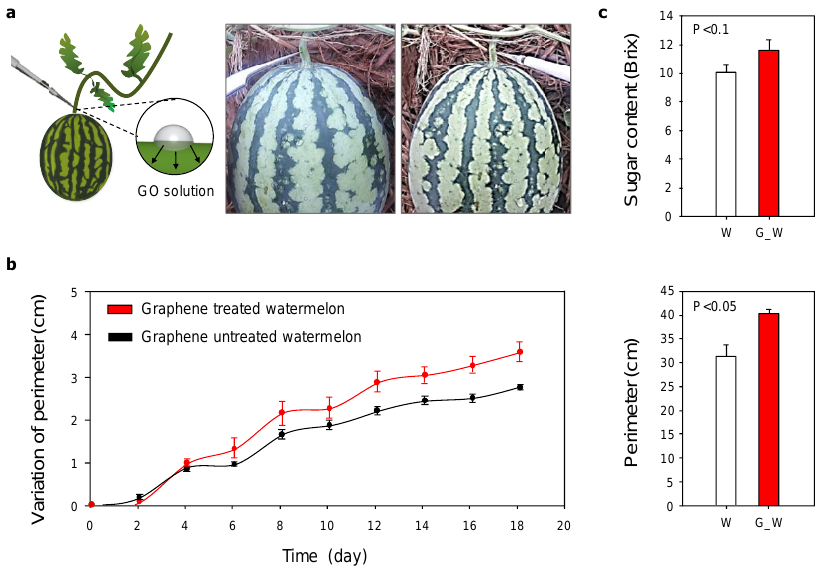
Figure 3. Effect of graphene oxide (GO) on watermelon. ( a ) Schematic of GO solution injection into the watermelon stem. ( b ) Effect of GO on the rate of perimeter change and the final watermelon perimeter. ( c ) Sugar contents in GO-treated watermelons (G_W) and untreated watermelons (W) ( n = 4).